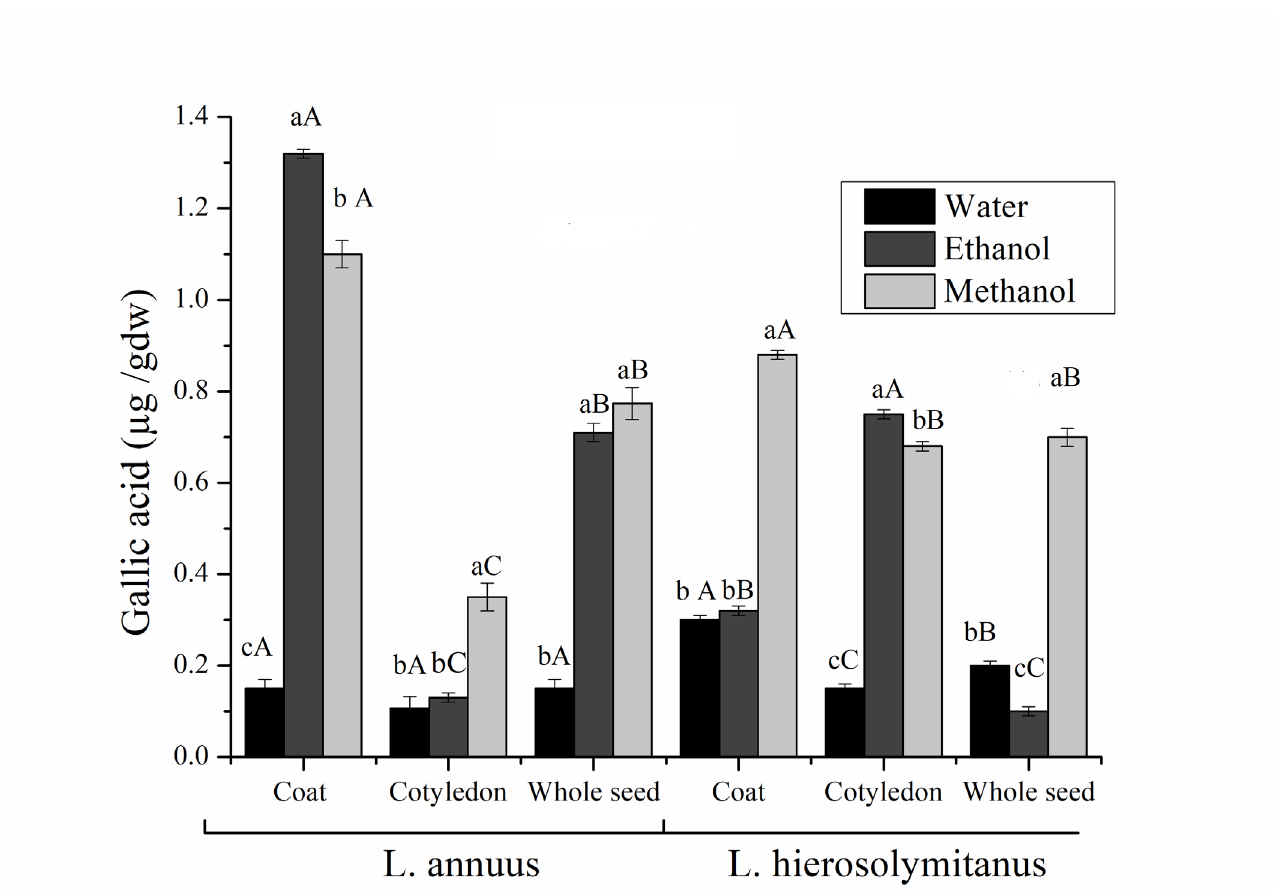
FIGURE 1 - Distribution of gallic acid in Lathyrus seed extracts. Different letter show differences of means among different solvents for each part of each plant species (p < 0.05). Different caps letter shows differences between extracts from different part of the plant in the same solvent for Lathyrus species (p <